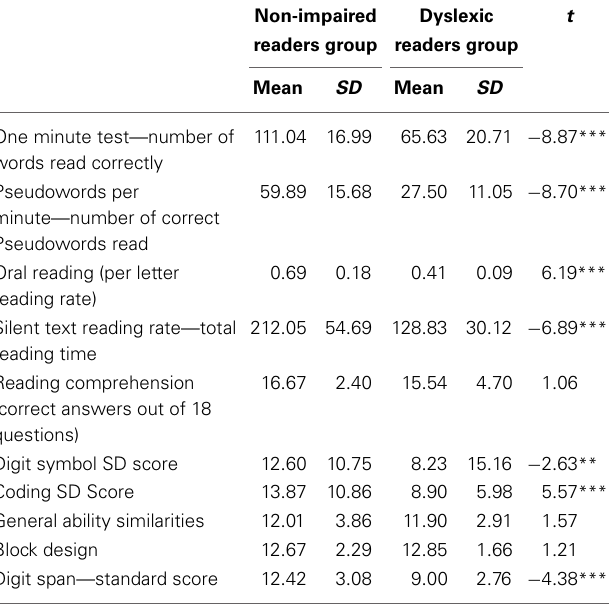
Table 1 | Reading and cognitive measures for dyslexic and non-impaired